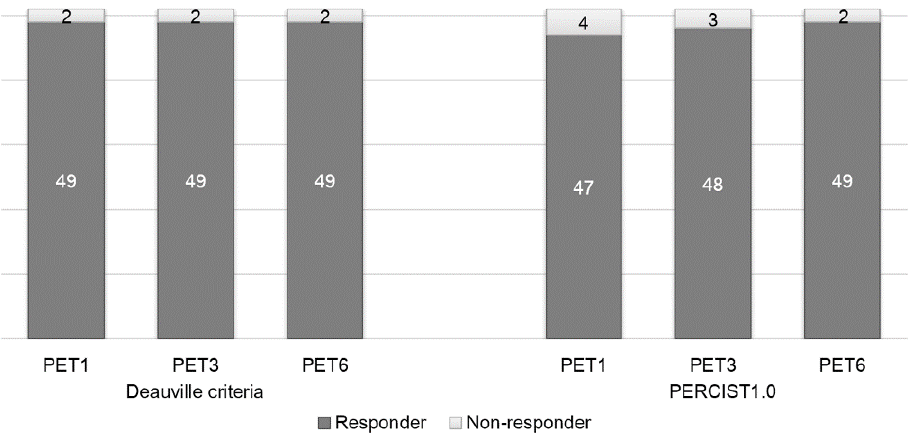
Figure 3. Number of responders and non-responders at each time point according to the two response